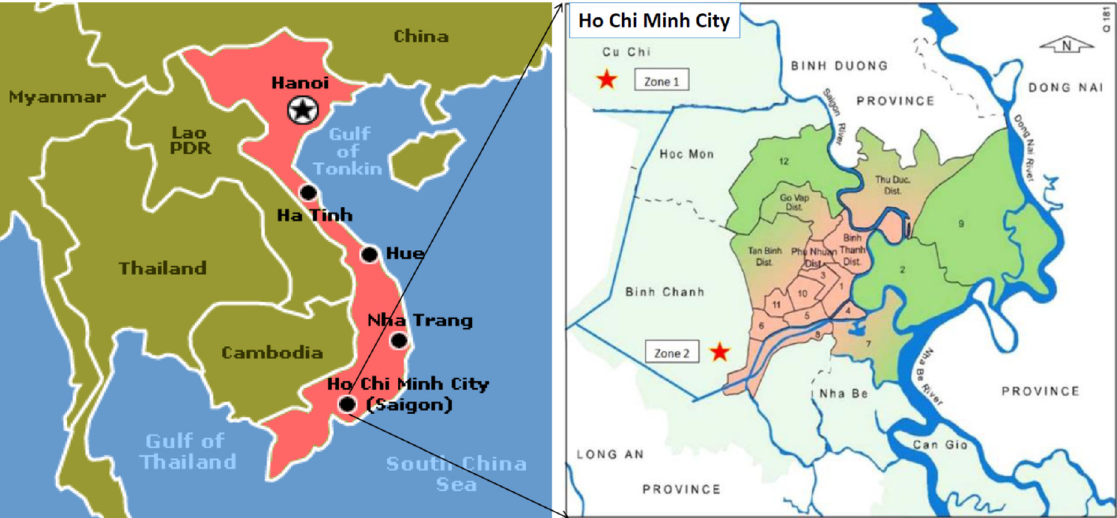
Figure 2. Location of Ho Chi Minh City (10.75° N, 106.67° E) in Viet Nam. The map (right side) is adopted from ISSOWAMA (Integrated Sustainable Solid Waste Management) in the Asia project report [8]. Zone 1 and Zone 2 (indicated with stars) are two major sanitary landfill sites in Ho Chi Min City.